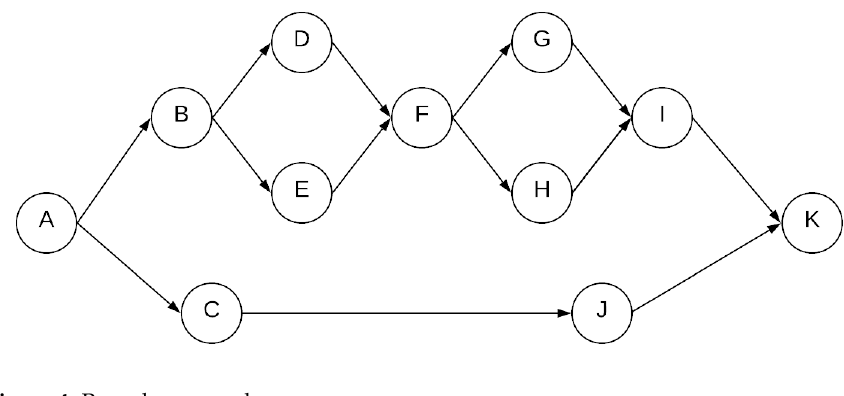
Figure 4. Precedence